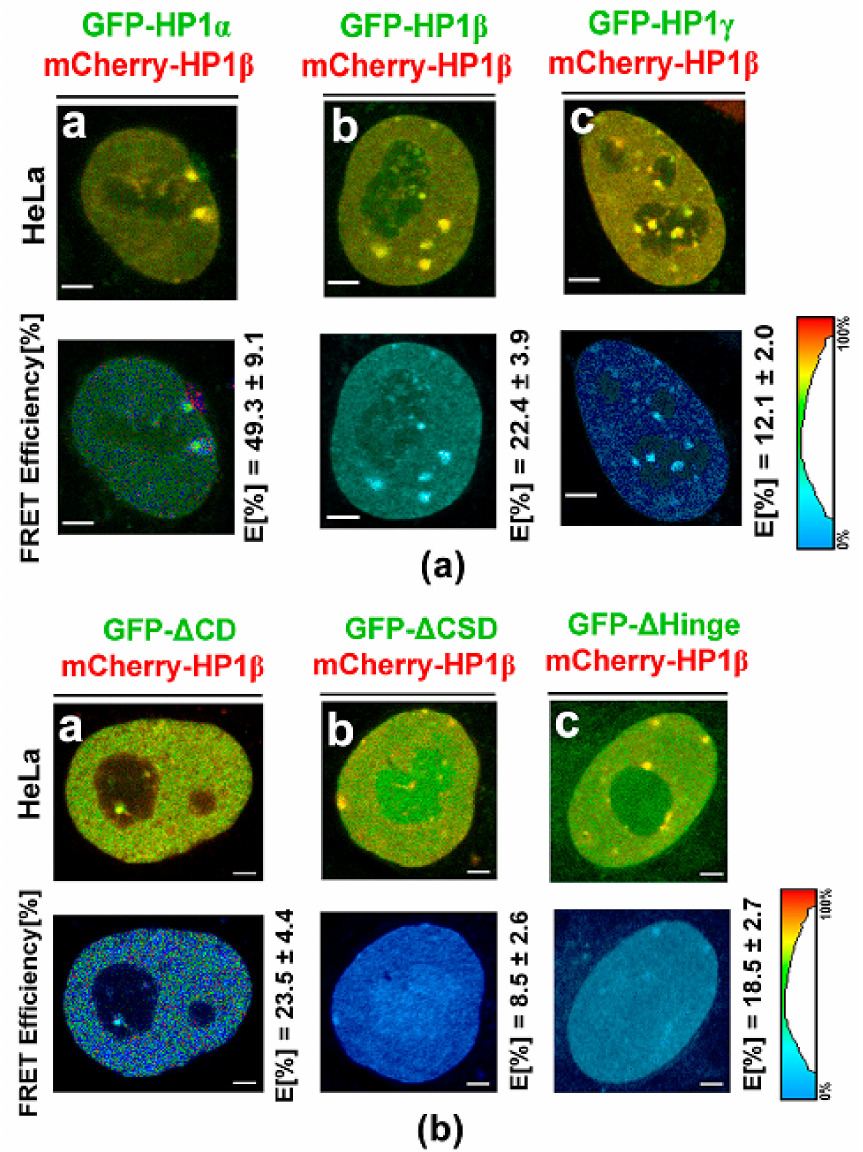
Figure 10. Fluorescence lifetime imaging-Forster resonance energy transfer (FLIM-FRET) analysis of potential interaction between HP1 α , HP1 β , and HP1 γ . Following interactions were studied: ( a ) a) GFP-tagged HP1 α / mCherry-HP1 β , b) GFP-tagged HP1 β / mCherry-HP1 β , c] mCherry-HP1 β / GFP-tagged HP1 γ . E (%) means FLIM-FRET